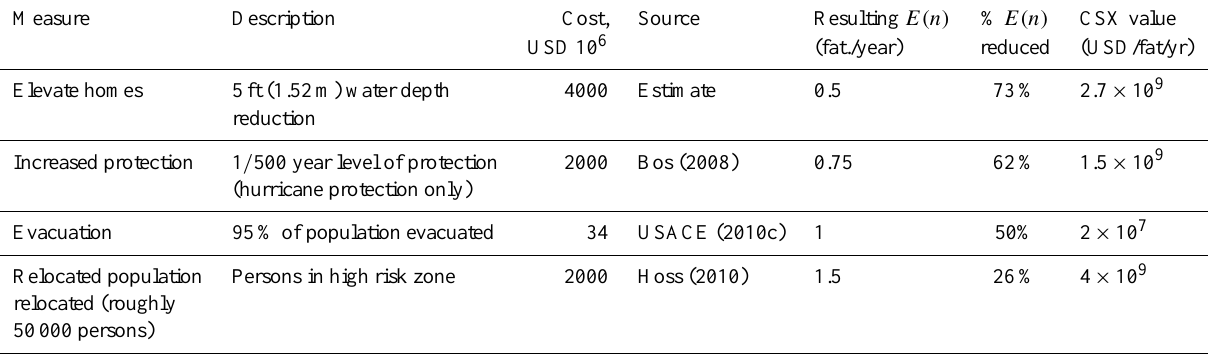
Table 3. Preliminary cost estimates and resulting CSX values for risk reduction measures. Results are for illustration purposes, further investigation of measures, associated costs and risk reduction is